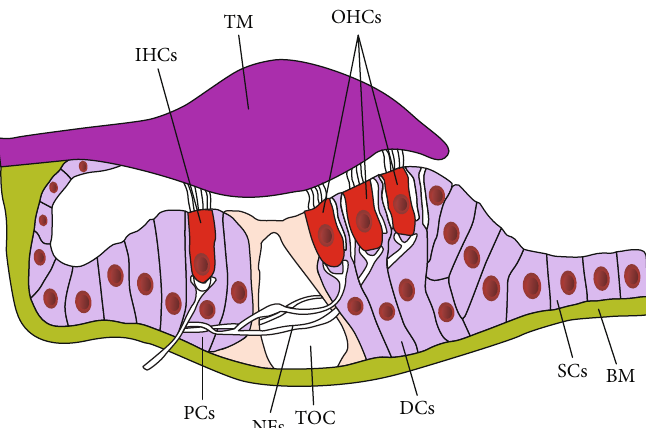
Figure 1: Schematic of the adult mammalian organ of Corti showing the normal arrangements of sensory and nonsensory cells on the basilar membrane. IHCs: inner hair cells; TM: tectorial membrane; OHCs: outer hair cells; PCs: pillar cells; NFs: nerve fi bres; TOC: tunnel of Corti; DCs: Deiters ’ cells; SCs: supporting cells; BM: basilar